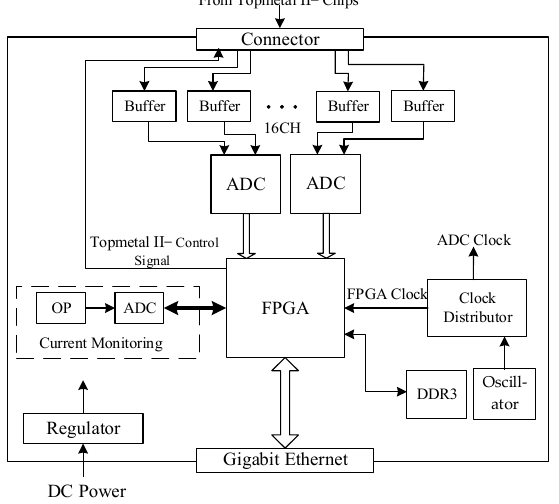
Figure 5. Block diagram of RCM.